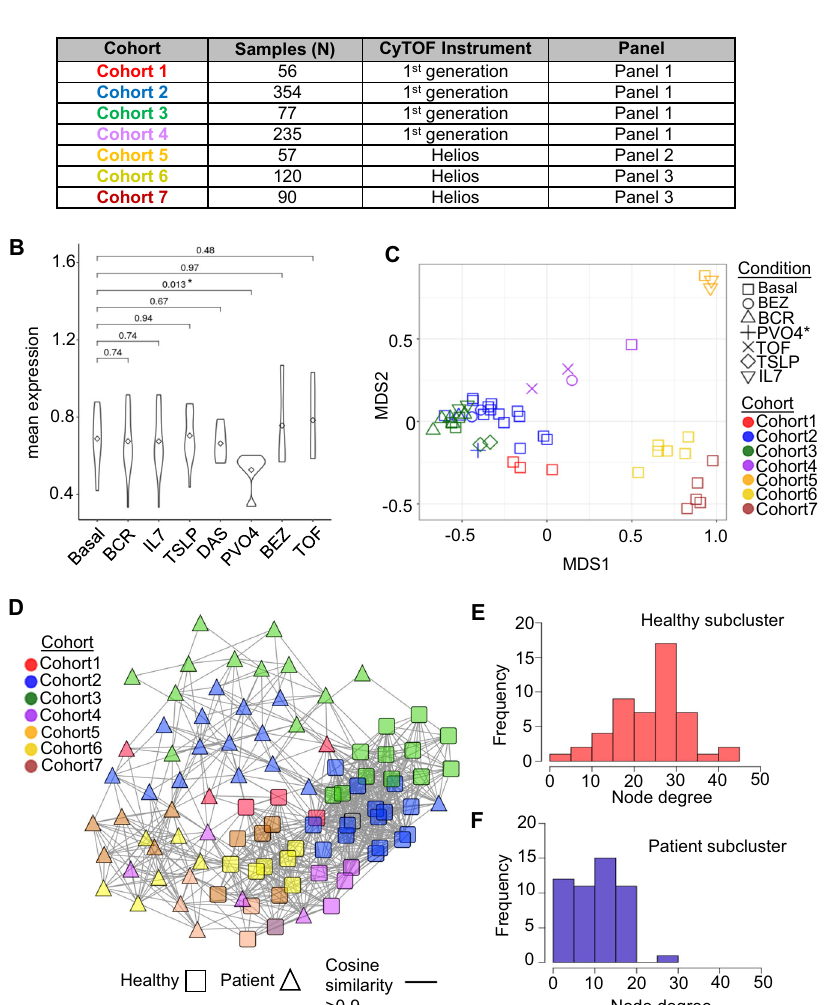
Fig. 2 Characterization of healthy controls as generalized anchors. A Seven cohorts of B-lymphoblastic leukemia samples were collected during 2014 – 2019. The samples were collected on two different CyTOF instruments using three antibody panels with slight variations in naming conventions, the number of proteins measured, and protein-metal labels. B Effects of ex vivo perturbation with cytokines or small molecules on the mean expression of 36 consensus markers in the healthy control samples. The signi fi cance of the overlap in the distribution was quanti fi ed by P -values using a two-sided Wilcoxon test across 36 protein markers comparing basal v. perturbation conditions. The perturbation conditions include B-cell receptor cross-linking (BCR), Dasatinib (DAS), thymic stromal lymphopoietin (TSLP), BEZ-235 (BEZ), sodium orthovanadate (PVO4), tofacitinib (TOF), and IL-7 (IL7). C Multidimensional analysis of the 50 healthy controls from 7 cohorts. Note that shapes represent conditions and colors represent cohorts. D Unsupervised clustering of both healthy and patient samples using an expression similarity network where nodes represent samples and edges represent the cosine similarity between sample mean expressions. The healthy samples form a highly connected subcluster distinctly separated from that of the patient samples using a stringent similarity threshold of 0.9. Comparison of node degree (number of connected edges) distribution between ( E ) healthy (red) and ( F ) patient subclusters (blue). The healthy subcluster exhibited a higher degree of network connectivity (node degree avg = 24.4) to the patient subcluster (node degree avg = 10.9), as revealed by denser between-node edges, indicating smaller within-sample variations. Source data are provided as a Source Data fi